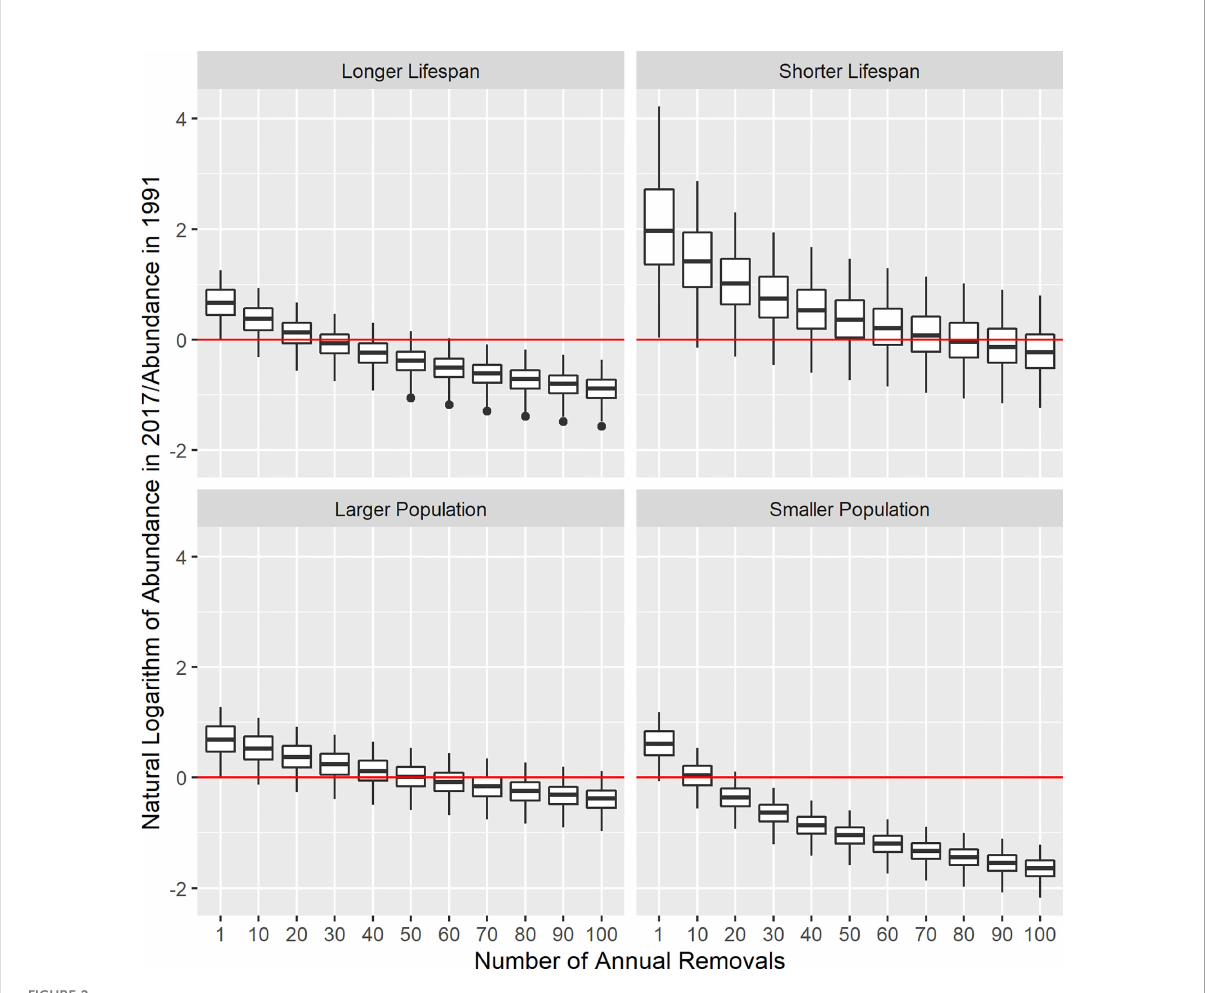
FIGURE 2 Boxplots representing the ratio of abundance in the terminal year (2017) as compared to predicted abundance in 1991, plotted on a log scale for each life history scenario and level of removals. The horizontal line represents the median, the box is drawn around the fi rst and third quartile and the whiskers approximate a 95% con fi dence interval. Positive values indicate abundance increase, negative values indicate decline, with the red horizontal line at zero (no change). The median value must be > 0 for 50% of simulations to be increasing from 1991 to